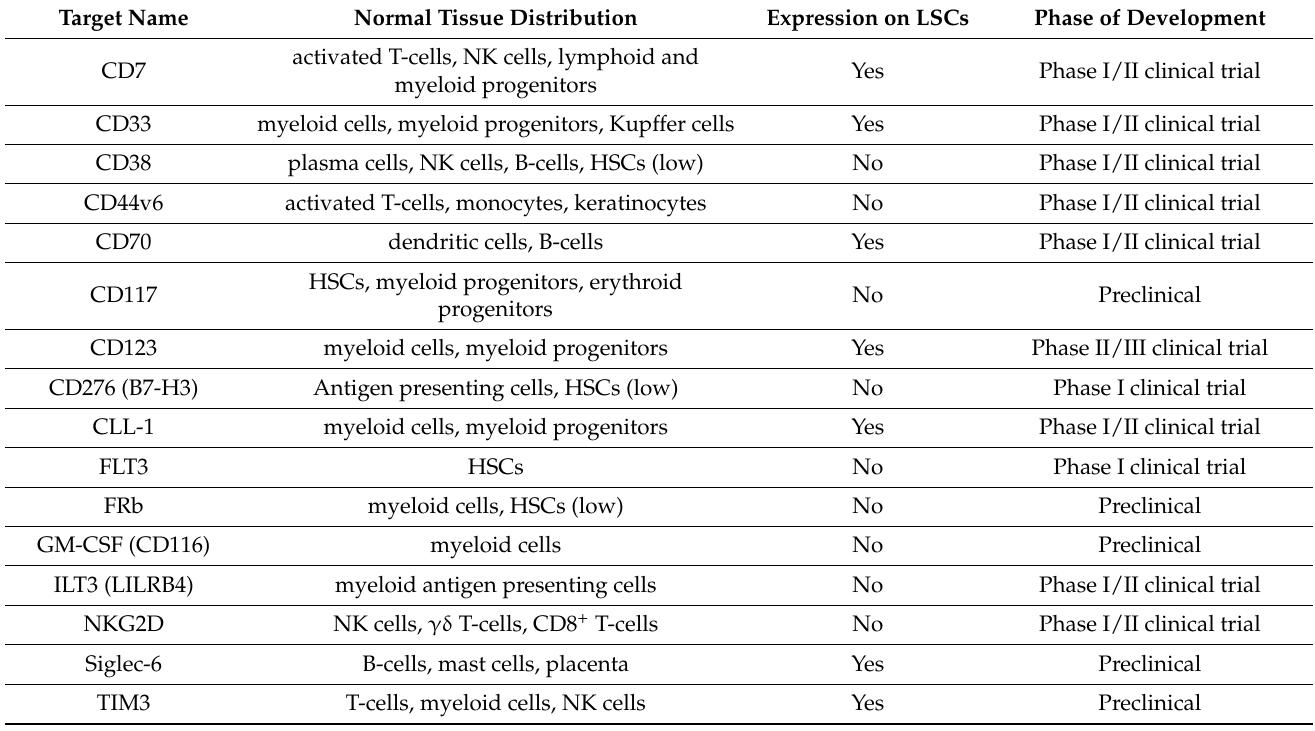
Table 2. Experimental Targets in AML